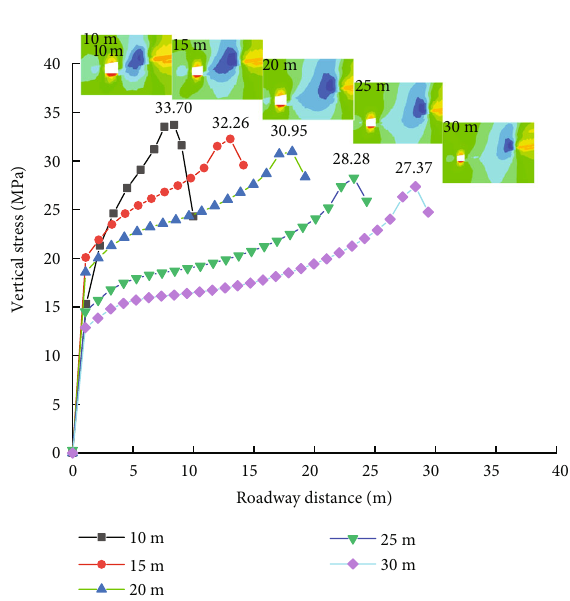
Figure 9: Distribution of vertical stresses on coal pillar with di ff erent